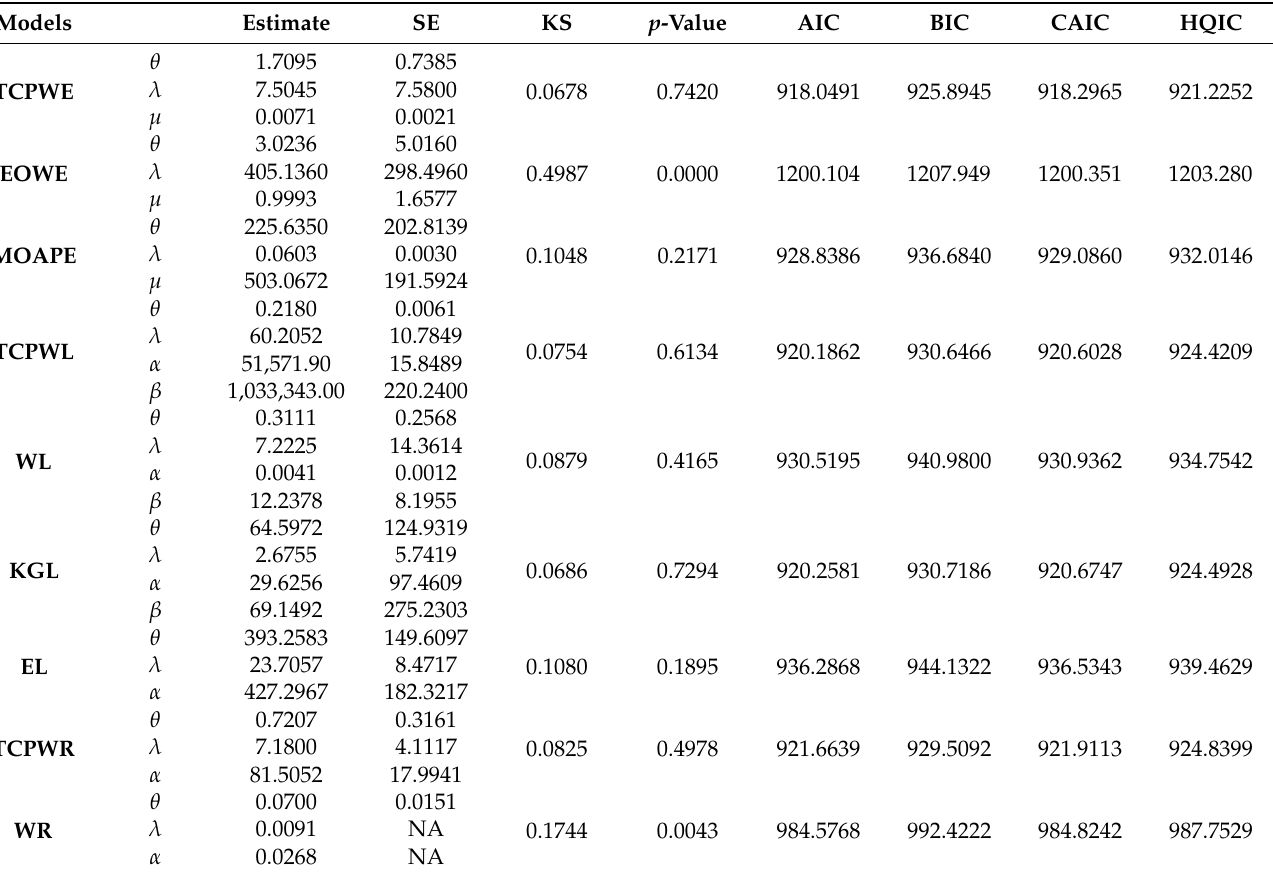
Table 5. Estimates, SE, goodness-of-fit test by using KS and different criteria measures for fatigue times.